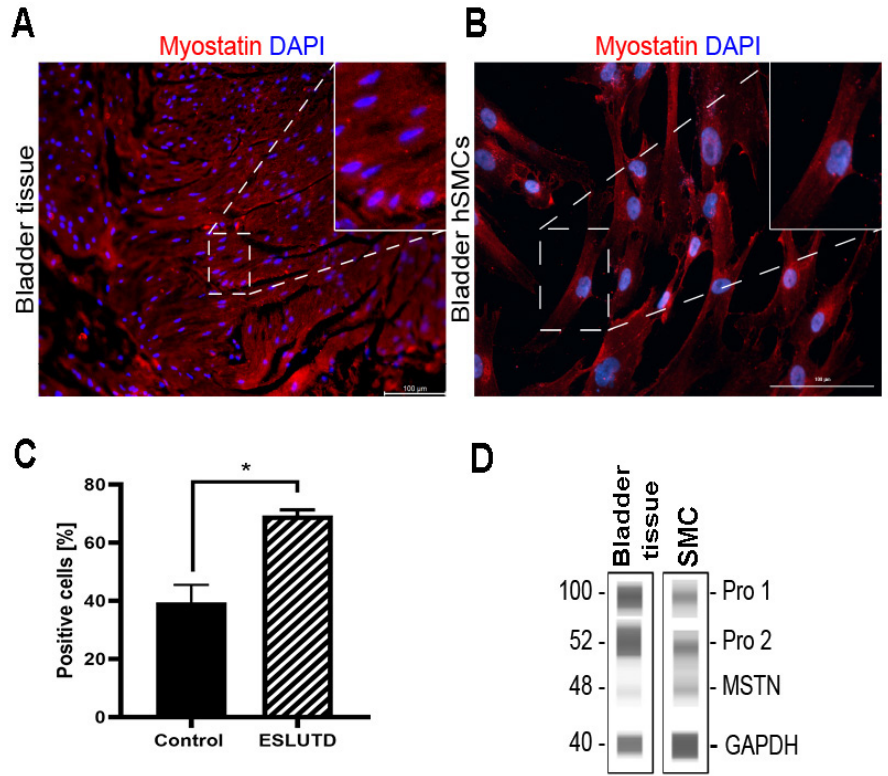
Figure 1. Myostatin expression in human bladder smooth muscle tissue and cells. ( A ) Immunofluorescence staining image of myostatin protein (red) in pediatric bladder muscle tissue. Cell nuclei stained with DAPI (blue). 10 × magnification ( B ) Immunofluorescence staining image of myostatin protein (red) in pediatric bladder-derived hSMCs. 20 × magnification ( C ) Flow cytometry comparison of myostatin-positive cells in pediatric bladder-derived control and ESLUTD hSMCs. ( D ) Representative immunoblot by WES of active myostatin (48 kDa) and its propeptides (100, 52 kDa) in bladder-derived smooth muscle tissue and cells. GAPDH (40 kDa) as a housekeeping protein. * p ≤ 0.05. Scale bar, 100 μ m.